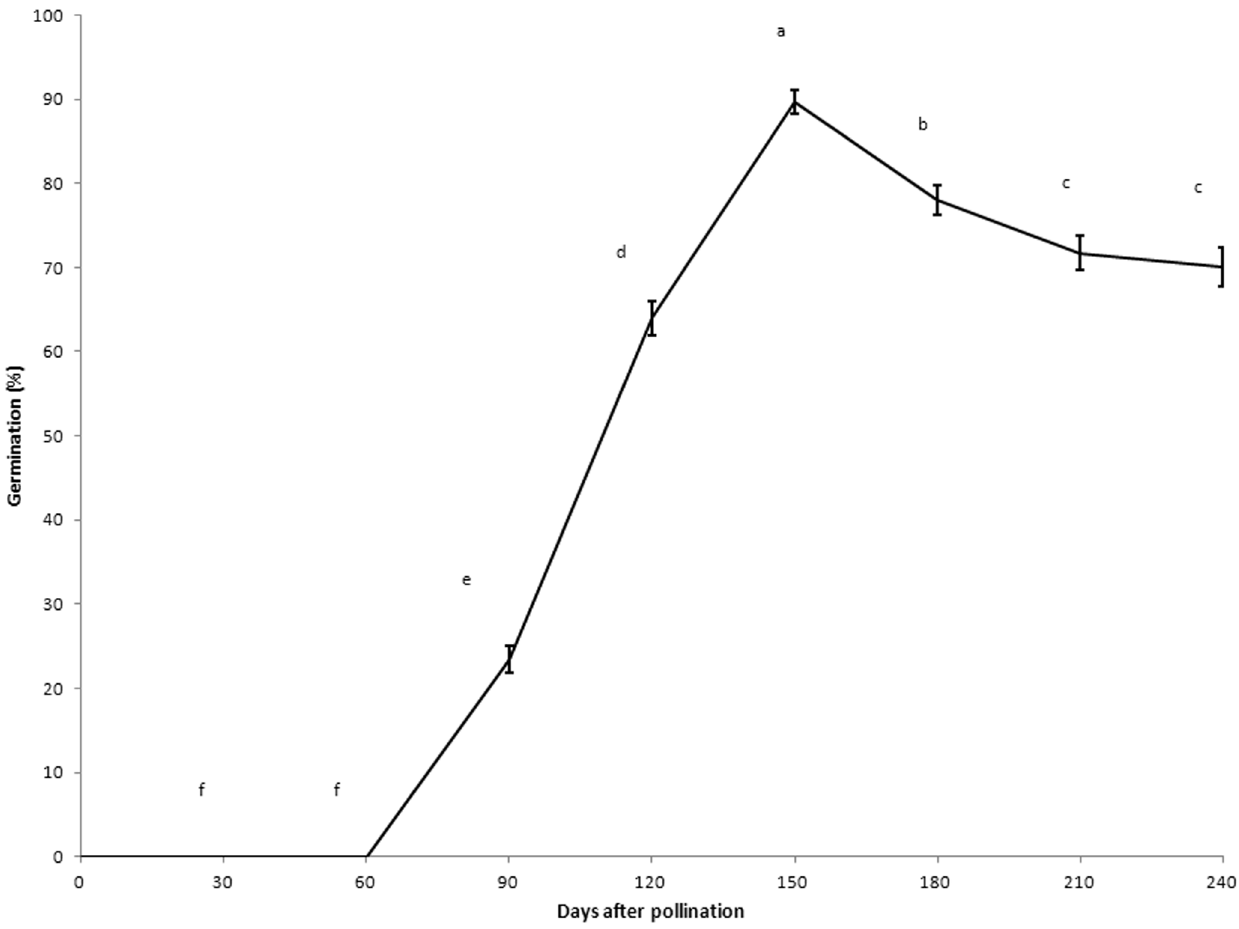
Figure 2. Effect of the degree of seed maturity on invitro germination of Renantheraimschootiana on quarter-strength MS medium supplemented with 0.5 mg l 2 1 NAA, 20% CW, 1.0 g l 2 1 peptone, 10 g l 2 1 sucrose and 1.0 g l 2 1 AC 75 days after culture. Different letters indicate significant differences between days at P , 0.05 (DMRT).